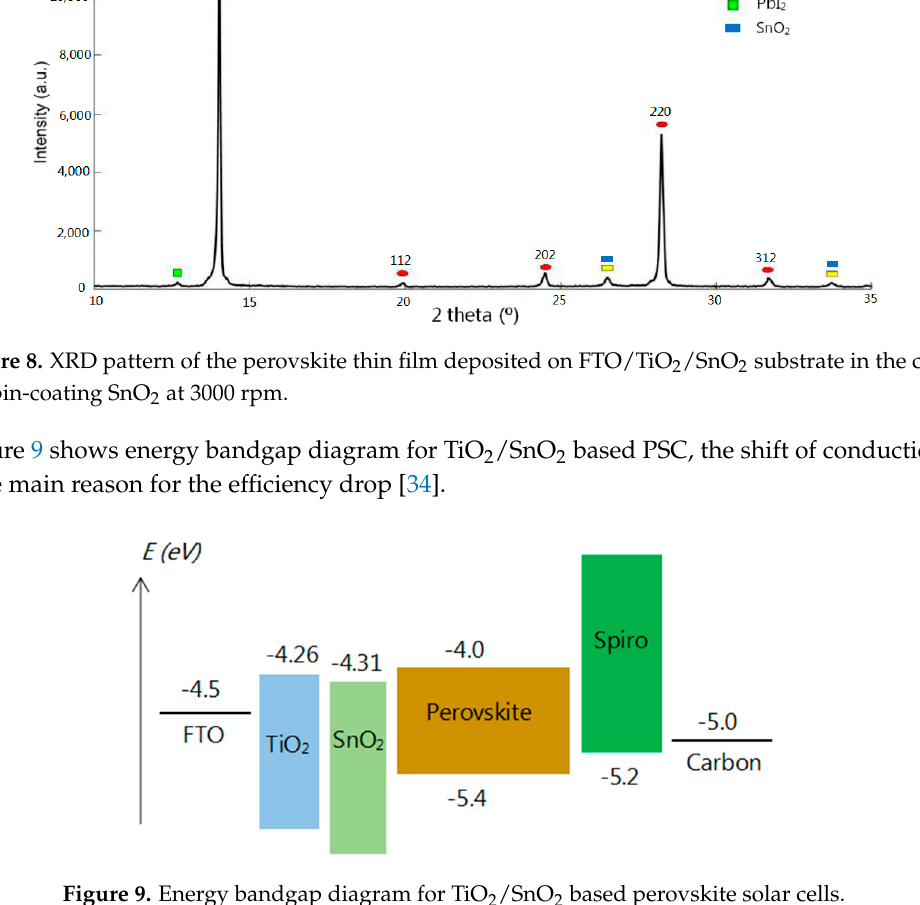
Figure 9. Energy bandgap diagram for TiO 2 /SnO 2 based perovskite solar cells.